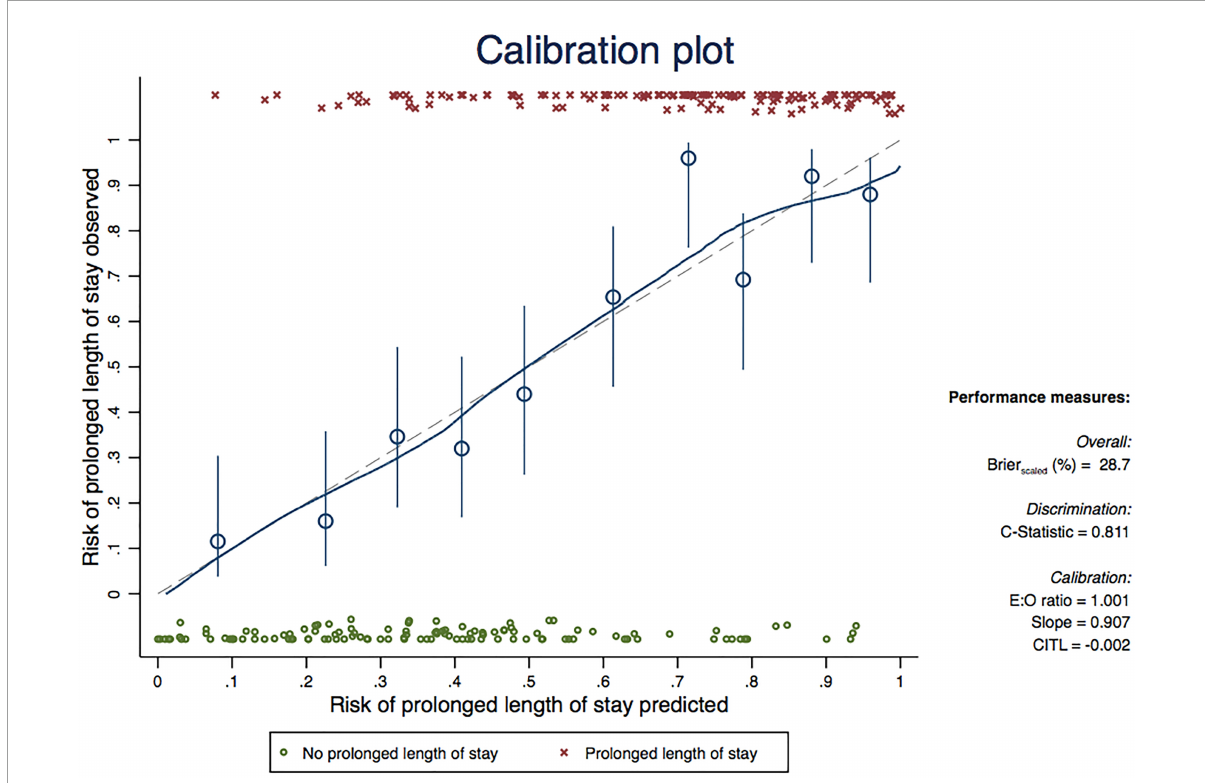
FIGURE1 Calibration plot comparing observed and predicted risk of prolonged length of stay in patients with osteoporotic femoral neck fracture (based on final model).